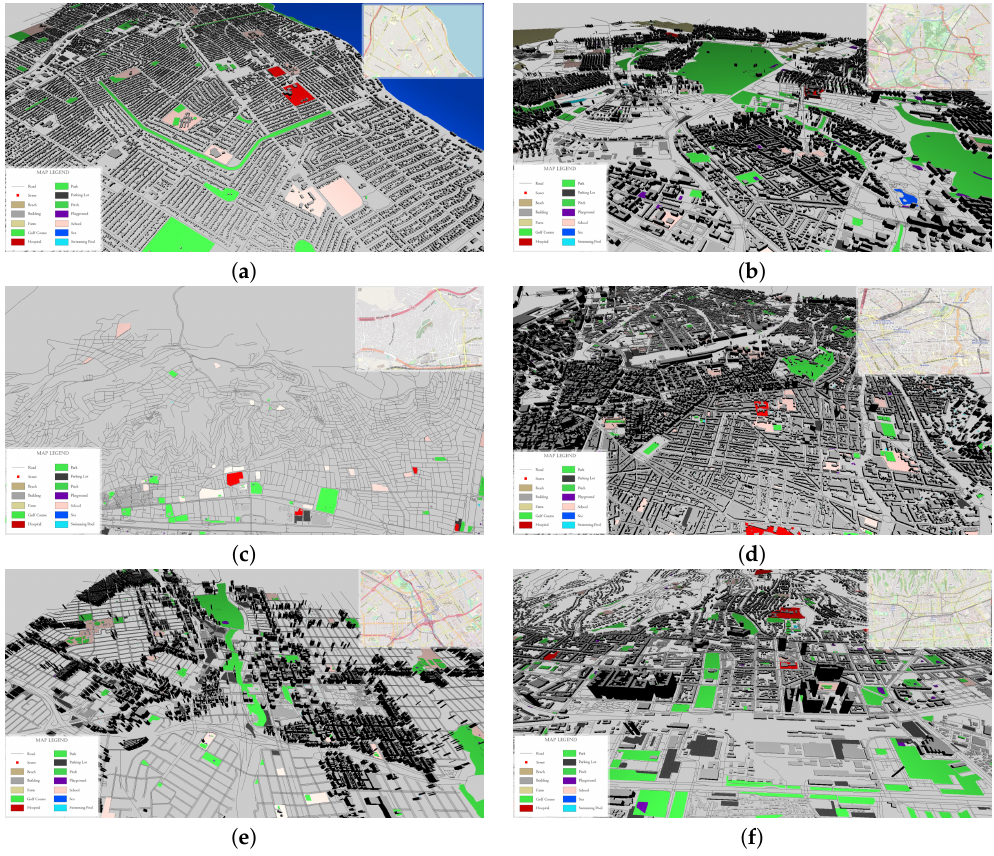
Figure 8. Visualization of six different cities: ( a ) Corpus Christi, TX, USA; ( b ) Frankfurt, Germany; ( c ) Izmit, Turkey; ( d ) Marseille, France; ( e ) San Jose, CA, USA; and ( f ) Zagreb,